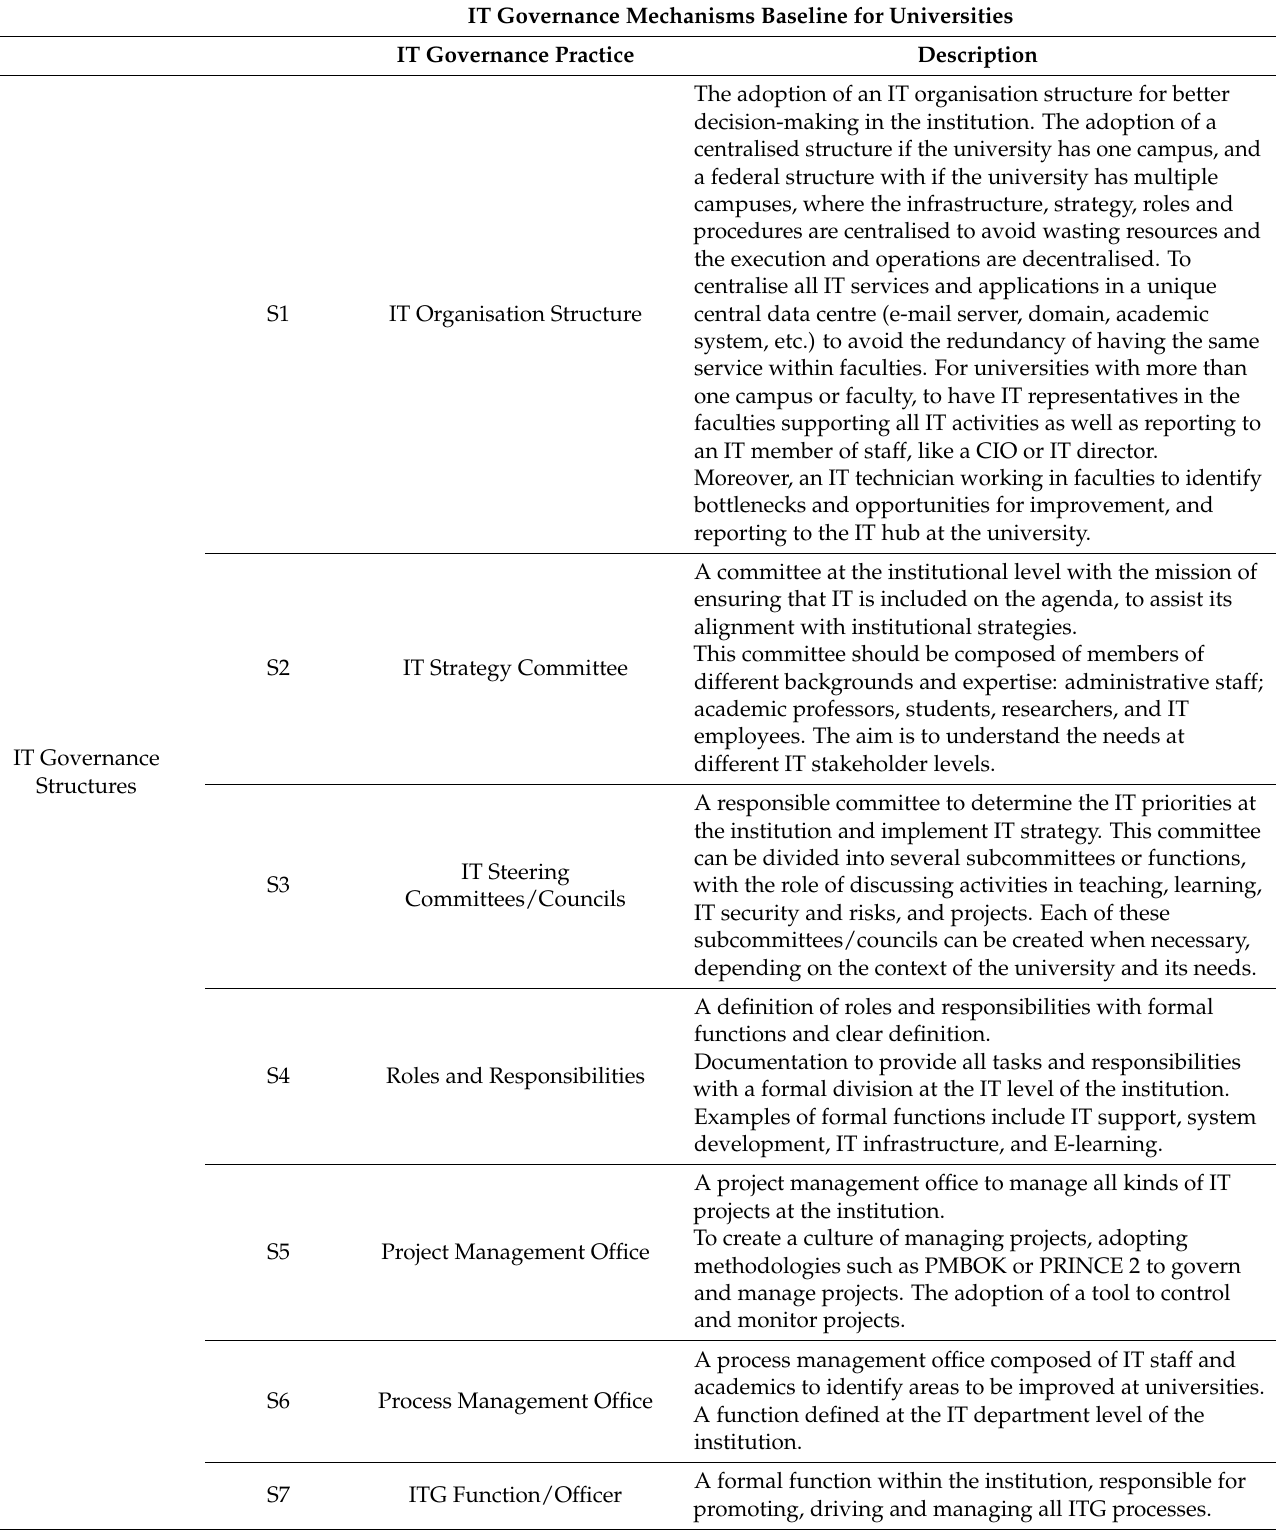
Table A1. IT governance Mechanisms Baseline for